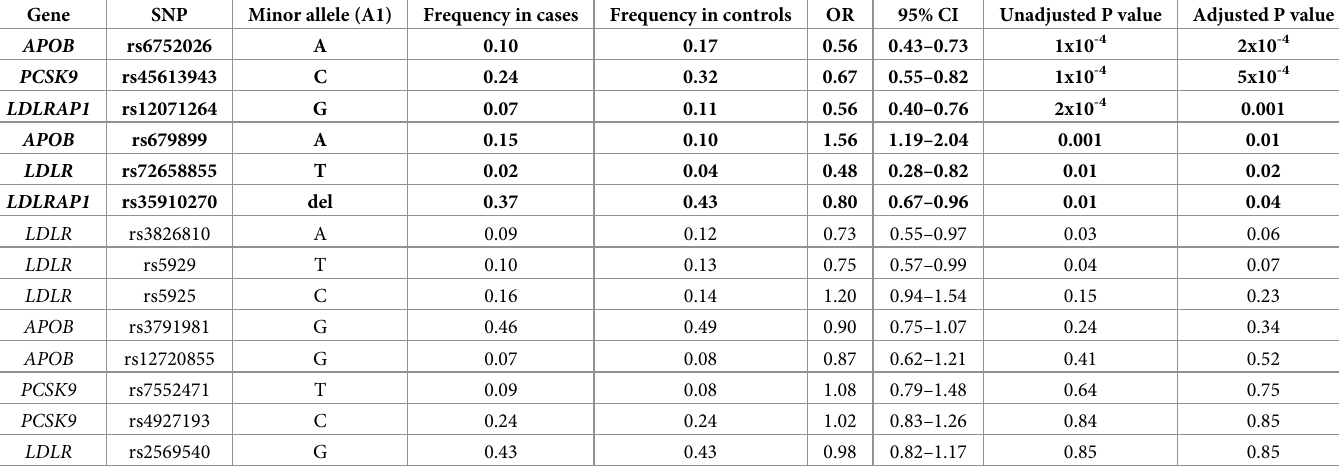
Table 3. Allelic association of 14 variants with and without adjustment for multiple testing in 993 individuals.